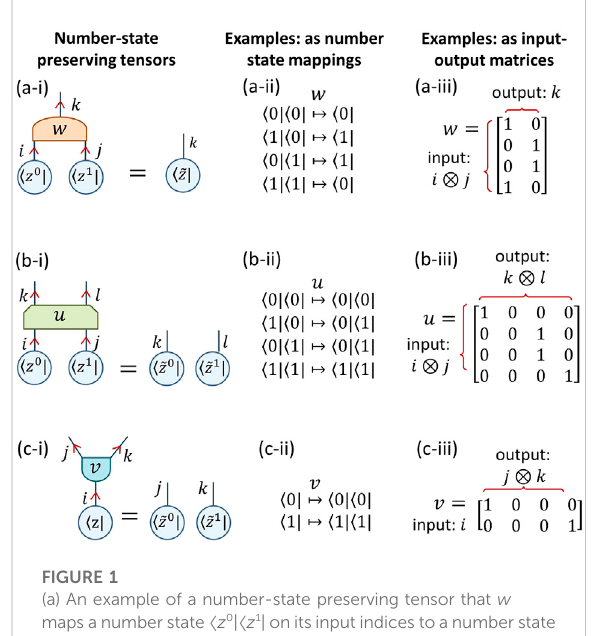
FIGURE 1 (a) An example of a number-state preserving tensor that w maps a number state 〈 z 0 | 〈 z 1 | on its input indices to a number state 〈 ~ z | on its output index. The tensor w can be equivalently represented as (ii) an explicit mapping between number statesor(iii)asamatrix(afterforming theproductofinputindices). (b) An example of a number-state preserving tensor u between two input and two output indices. (c) An example of a number- state preserving tensor v between one input and two output indices. Note that the three examples of number-state preserving tensors from (a-c) are also unital , in that all of their non-zero entries are the unit